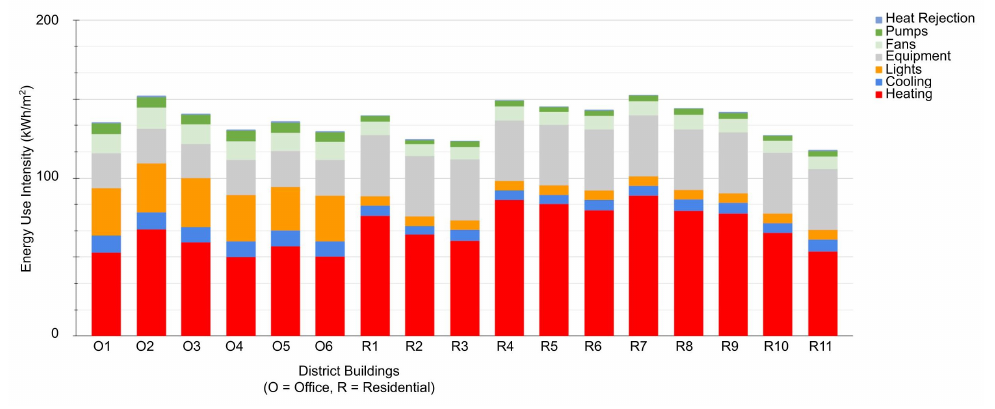
Figure 13. Annual energy results for upgraded HVAC systems.